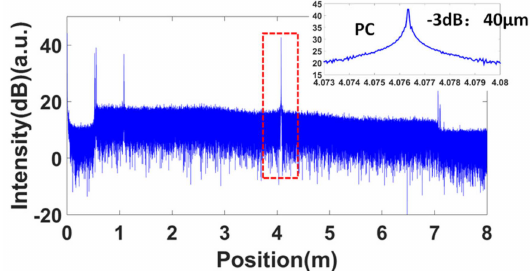
Figure 9. Measured OFDR trace without nonlinearity correction. The FWHMof the PC connector is about 1.5 m.